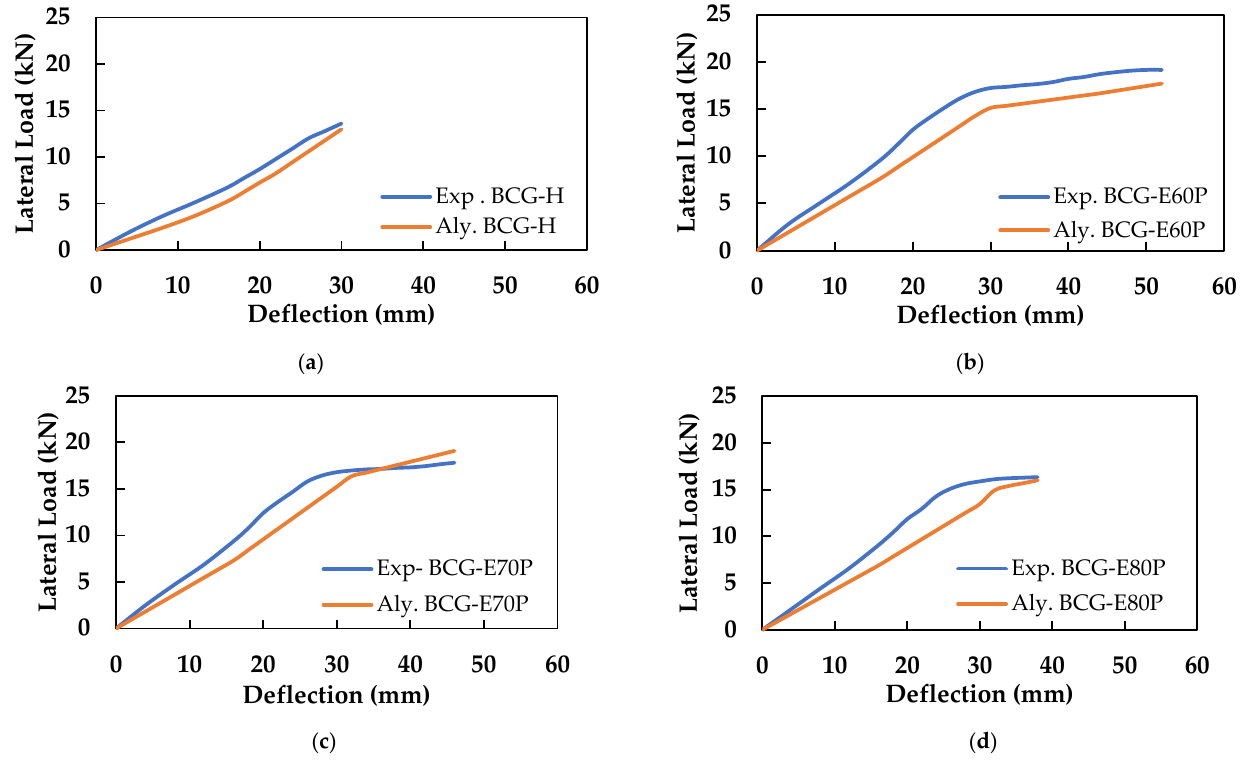
Figure 21. Comparison of load – displacement curves obtained from the experimental and numerical investigations. ( a ) BCG-H; ( b ) BCG-E60P; ( c ) BCG-E70P; ( d ) BCG-E80P.